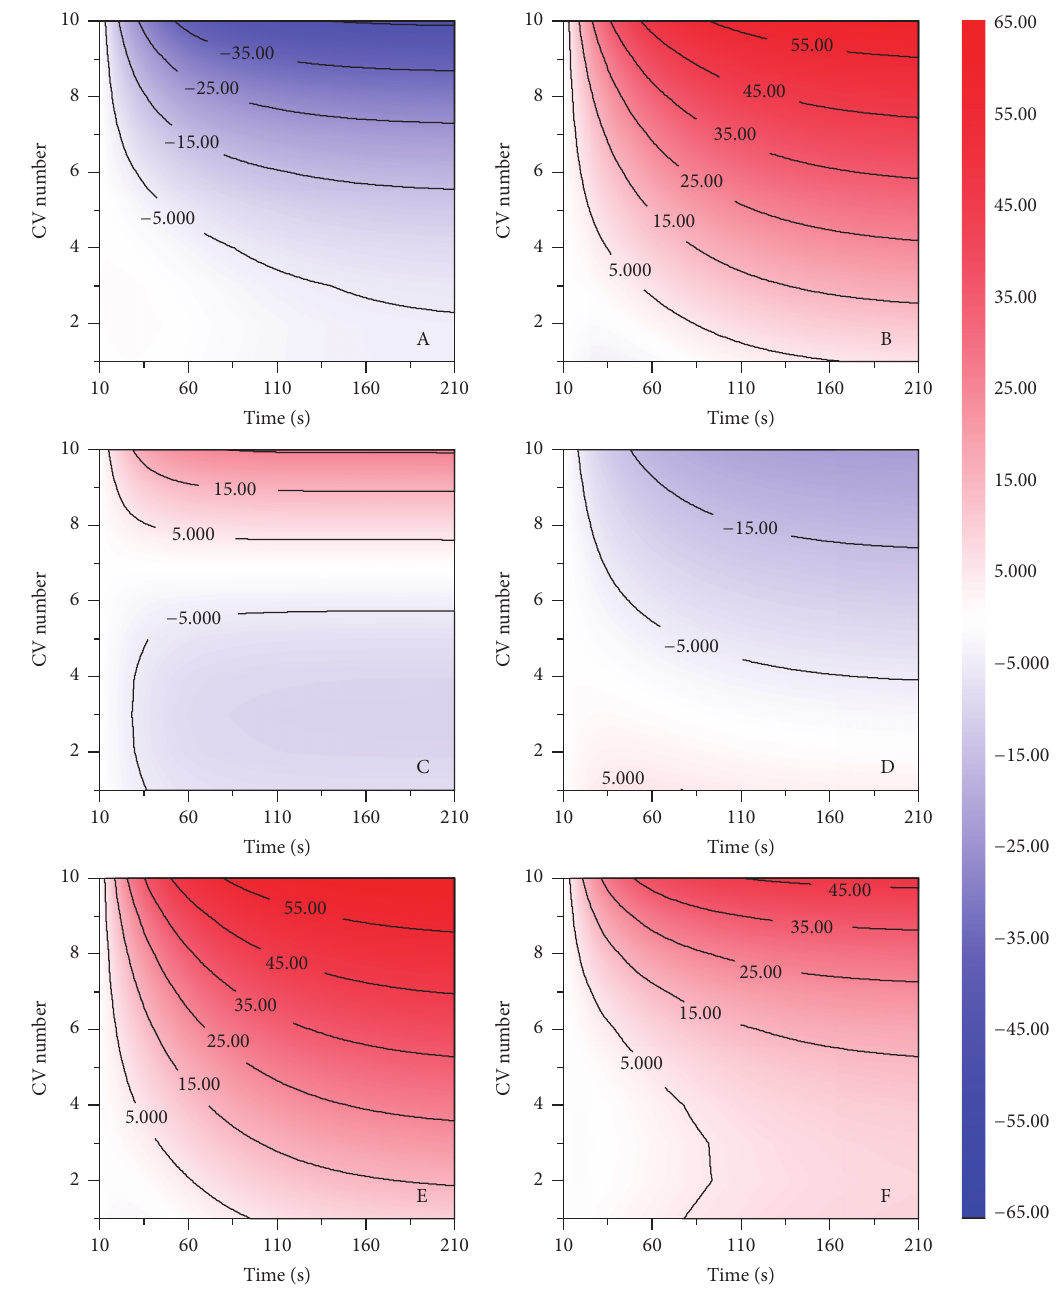
Figure 7: Recuperator core temperature responses to single bypass